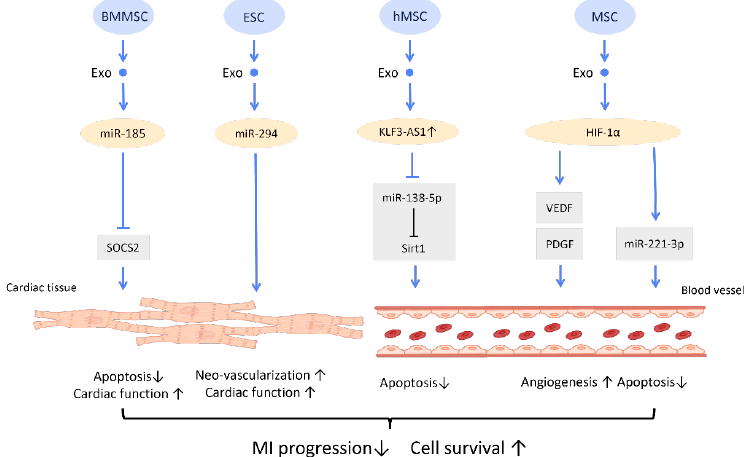
Figure 8. Molecular mechanisms of stem cell-derived exosomes for recovery from myocardial infarction. Molecular mechanisms of stem cell-derived exosomes for recovery from myocardial infarction. Stem-cell-derived exosomes are found to improve post-myocardial infraction recovery by inducing neo-vascularization and promoting myocyte survival. Abbreviation: Exo: exosome; SC: stem cell; MSC: mesenchymal stem cell; BMMSC: bone marrow-derived MSC; SOCS2: suppressor of cytokine signaling 2; hMSC: human MSC; miR: micro-RNA. ↑ represents upregulation; ↓ represents downregulation.